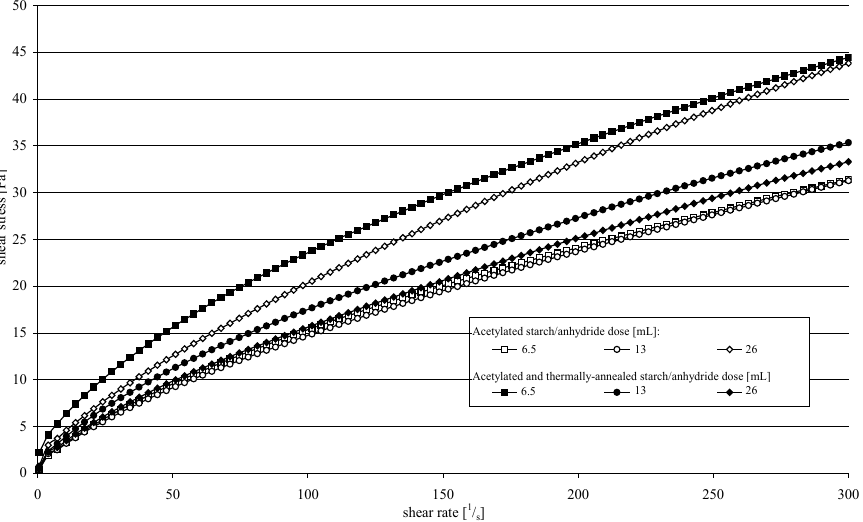
Figure 5. Flow curves of starch pastes prepared from acetylated starch and from acetylated and thermally-annealed starch.